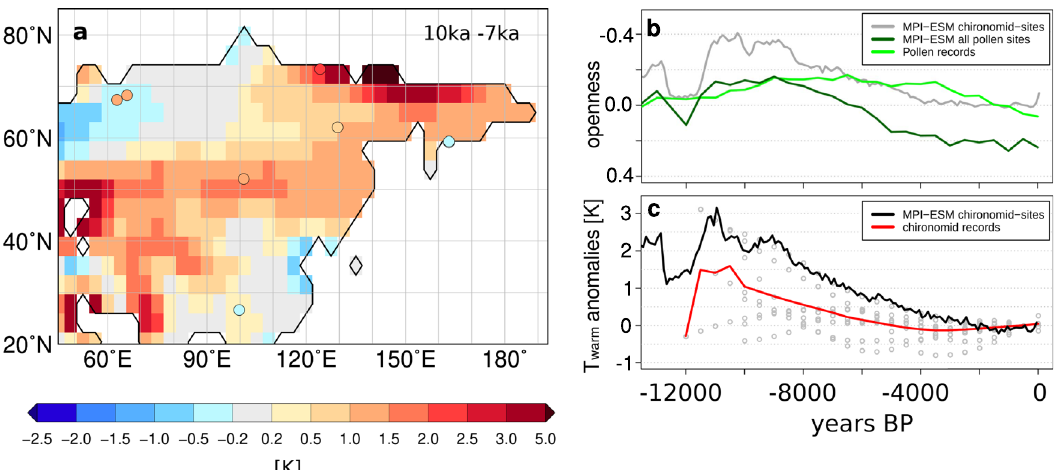
Fig. 5 | Comparison of the simulated temperature with chironomid-based reconstructions for Asia. The simulated July temperature is compared to chironomid-based July temperature reconstructions 60 . Only reconstructions that cover also the Early-Holocene have been used and interpolated on equal distant time-steps of 500 years. Shown are ( a ) the difference between the 10 ka and 7 ka timeslicesinthemodel(shaded)andthereconstructions(dots),preparedwiththe software GMT 5.4.3 80 . b The normalised openness index (cf. Figure 3) as simulated